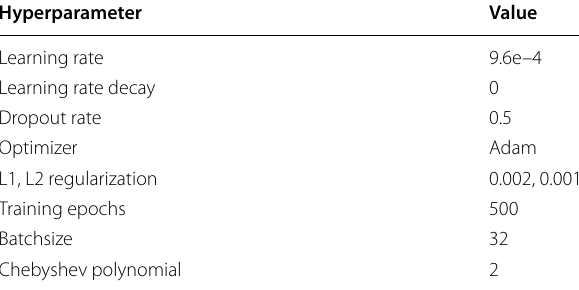
Table 1 The hyper-parameters of the model and their corresponding values